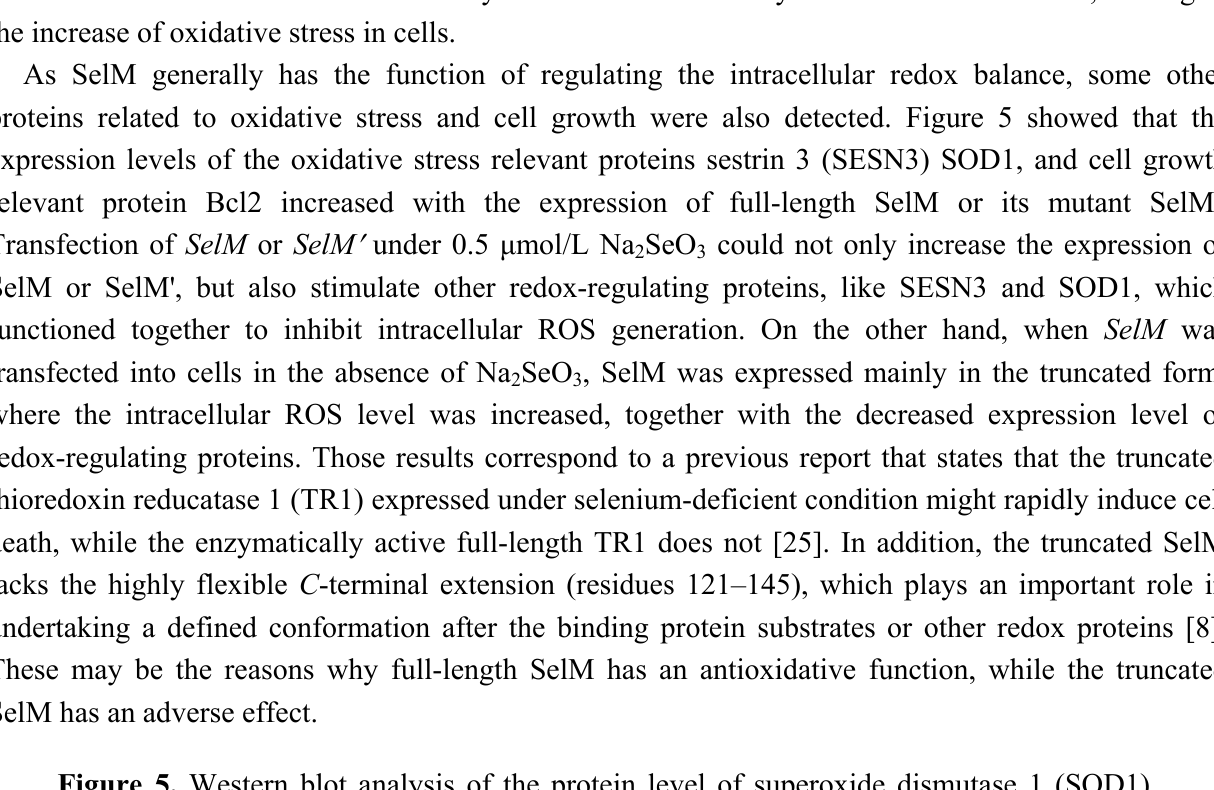
Figure 5. Western blot analysis of the protein level of superoxide dismutase 1 (SOD1), SESN3 and Bcl2. HEK293T cells were transfected with different plasmids with or